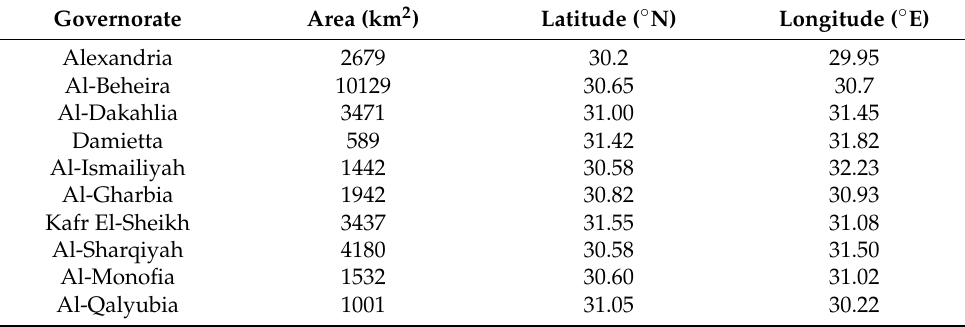
Table 1. The geographical coordinates and areas of the study